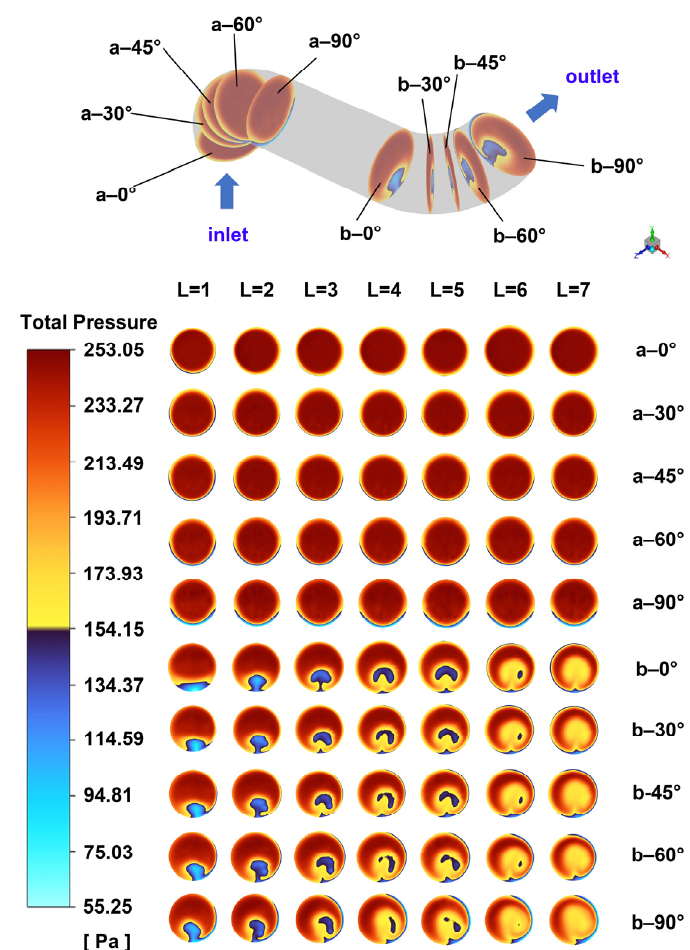
Figure 4. Position diagram of iso-surfaces and pressure distribution contours.